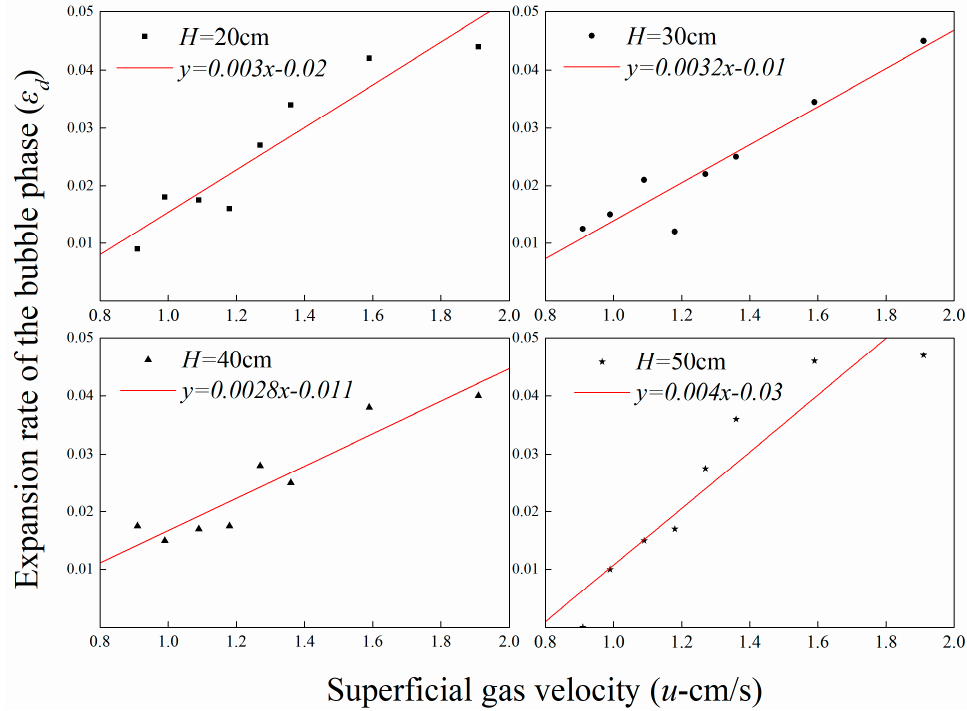
Figure 7. Effect of superficial gas velocity on the expansion of the bubble phase.